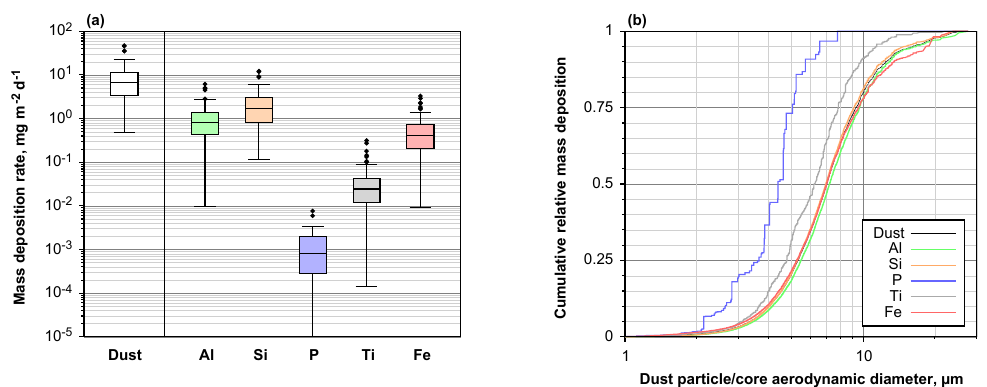
Figure 12. (a) Box plot of daily mass deposition rate for total dust and dust-derived elements on Barbados for 2013 and 2016. (b) Cumulative mass deposition flux as function of aerodynamic particle diameter for dust and dust-derived elements. Note that for P and Ti in the latter plot two particles containing each more than 10% of the total deposited mass have been removed from the data set.